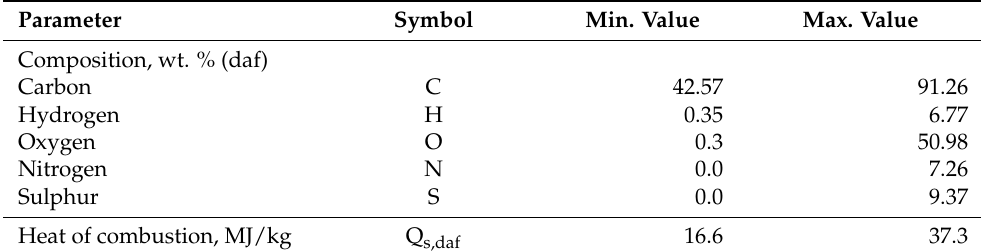
Table 4. Range of elemental compositions and heats of combustion.